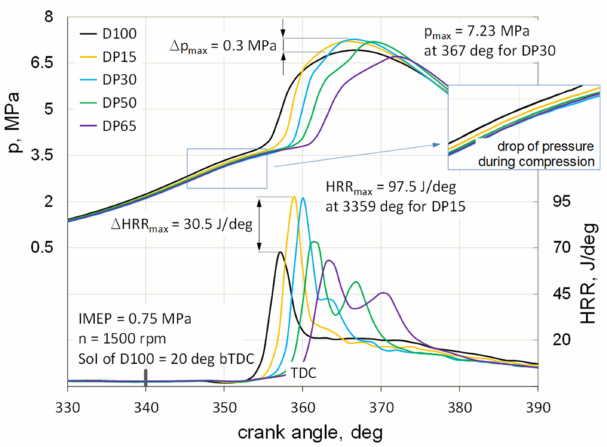
Figure 3. In-cylinder pressure (p) and heat release rate (HRR) characteristics for dual-fuel engine fueled by diesel and propanol with alcohol content from 0 to